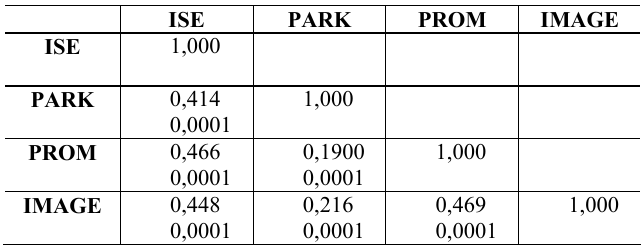
Table 3: Correlation matrix